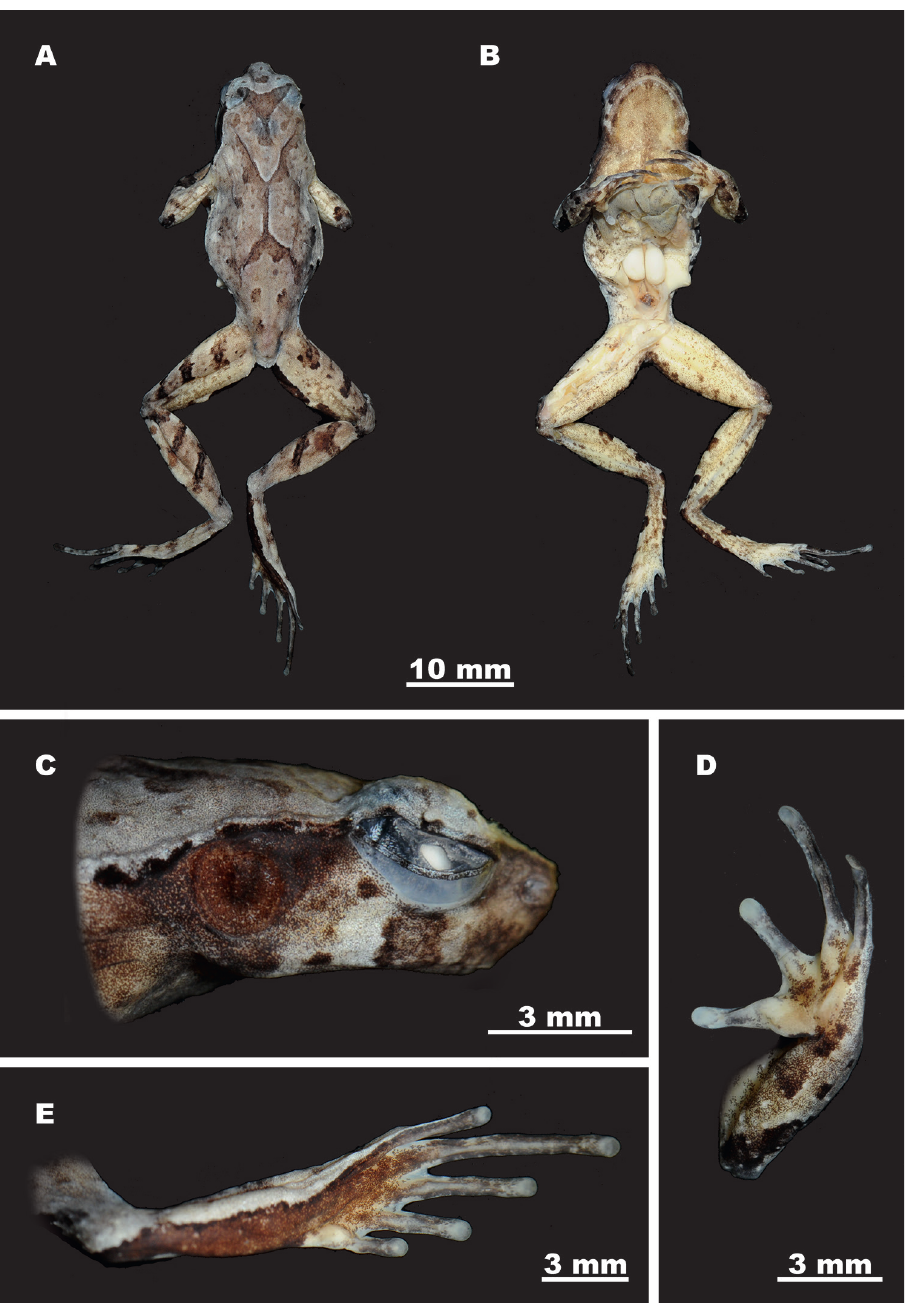
Figure 8. Holotype Ophryophryne elfina sp. n. (ZMMU A-5669, male, field number NAP-02658) in preservative: A dorsal view B ventral view C head, lateral view D volar view of the left hand E plantar view of the left foot. Photos by N.A.